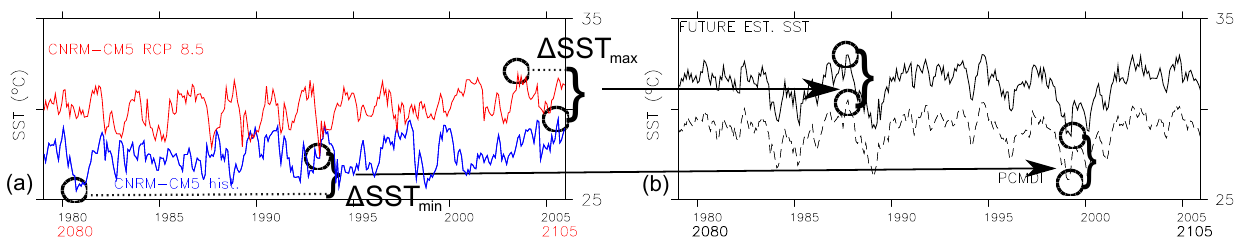
Figure A1. Illustration of the quantile–quantile method for min. and max. of SST time series for a grid point in the central Pacific: GCM historical simulation (blue, a ), GCM projected scenario (red, a ), observed SST (dashed, b ), reconstructed future SST (thick, b